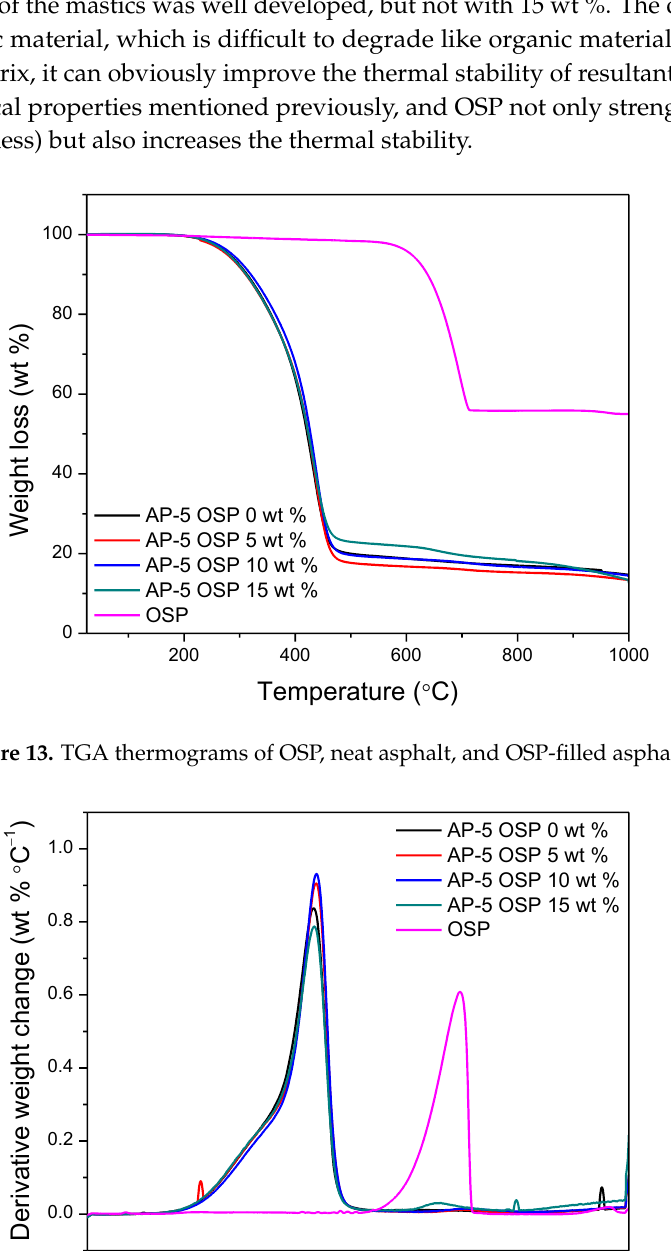
Figure 14. DTGA thermograms of OSP, neat asphalt, and OSP-filled asphalts. Table 5. TGA and DTGA thermogram data of OSP, neat asphalt, and OSP/asphalt blends containing 5, 10, and 15 wt % OSP loading at heating rate of 10 °C min −1 .